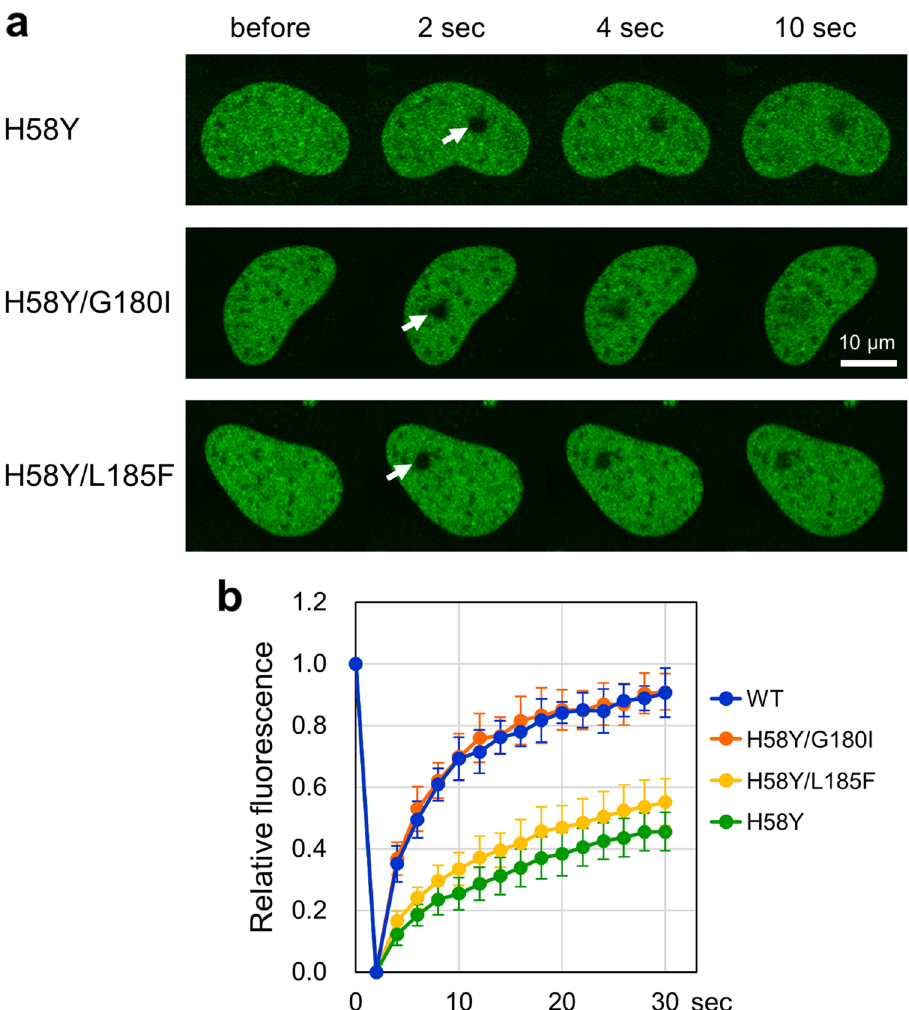
Figure 5. G180I restores the nuclear mobility of TOP2B H58Y. ( a ) Representative images of FRAP analysis of EGFP-TOP2B H58Y, H58Y/G180I, and H58Y/L185F. ( b ) Quantitative analysis of fluorescence recovery of EGFP-TOP2B WT, H58Y, H58Y/G180I, and H58Y/L185F (n = 10; bars, SD). The graphs of WT and H58Y are same as those in Fig. 2C. The mobile fractions were estimated as follows; WT: 0.87 ± 0.05, H58Y: 0.49 ± 0.05, H58Y/G180I: 0.87 ± 0.05, H58Y/L185F: 0.54 ± 0.08. The t1/2 of fluorescence recovery was calculated as follows; WT: 3.73 ± 0.95 s, H58Y: 8.81 ± 2.98 s, H58Y/G180I: 3.43 ± 0.69 s, H58Y/L185F: 6.60 ± 0.88